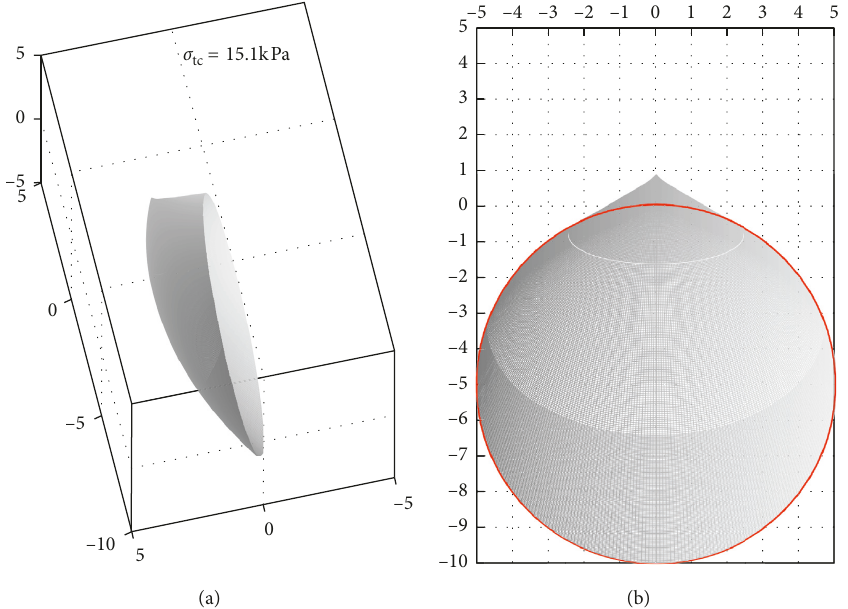
Figure 7: View of the critical failure surfaces of tunnel face in purely frictional soil with c